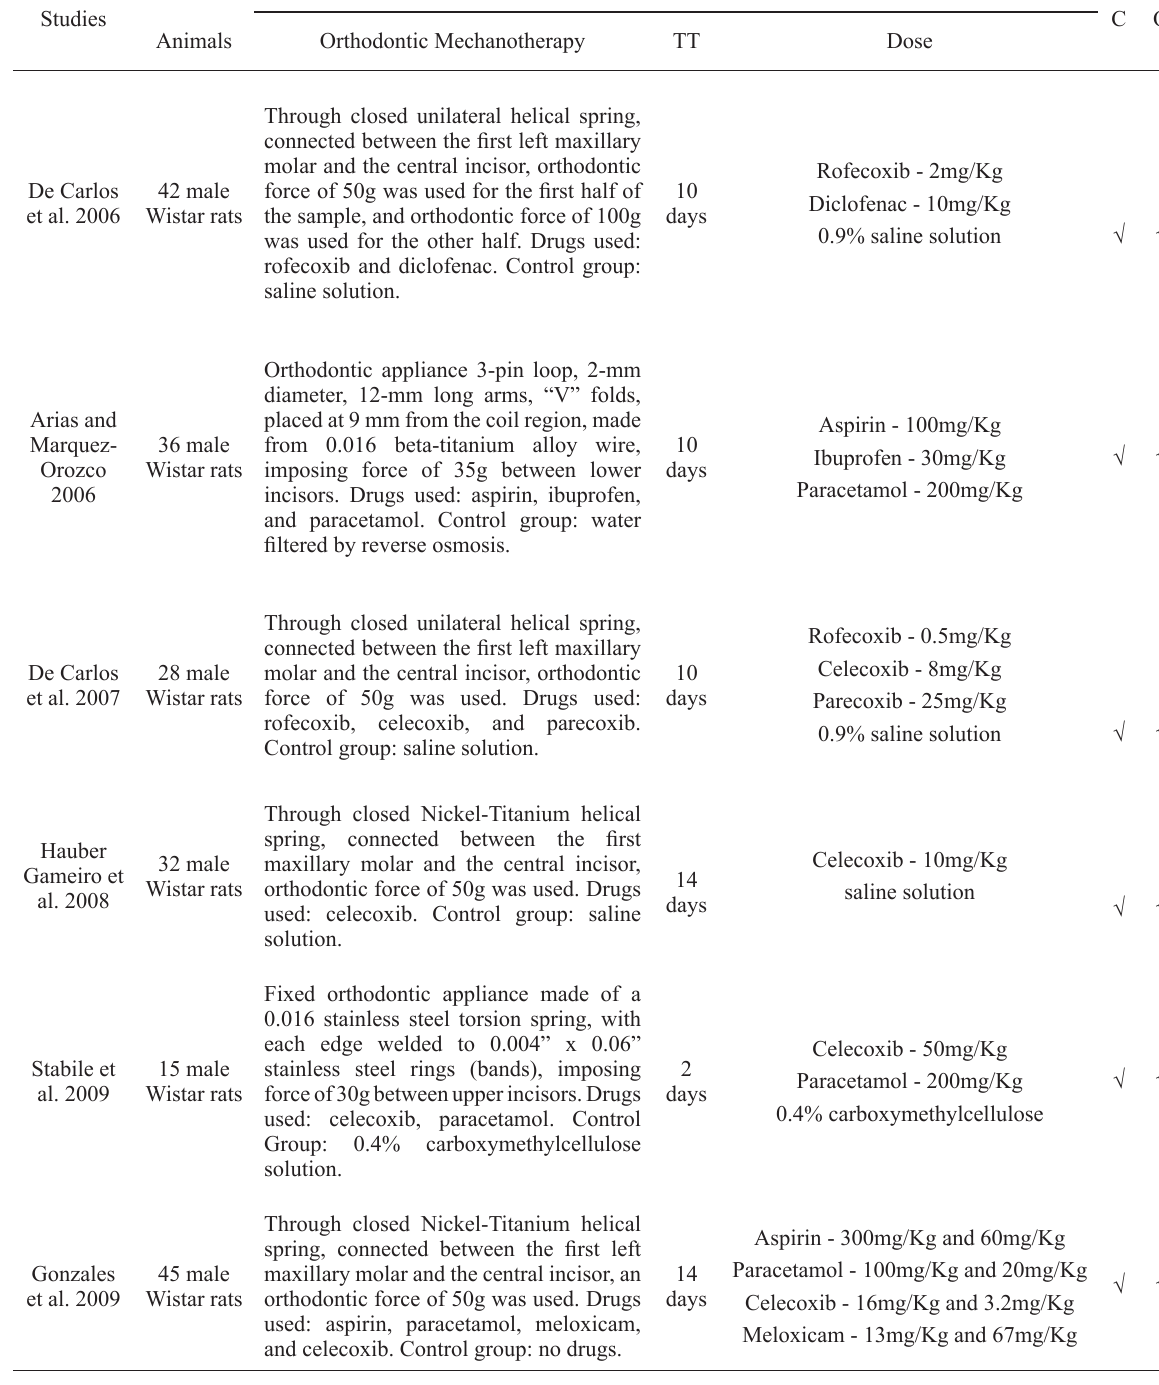
P: population; I: intervention; C comparison; O: outcomes; TT: time of treatment; √: comparison with control group and outcomes performed and reported in the study,